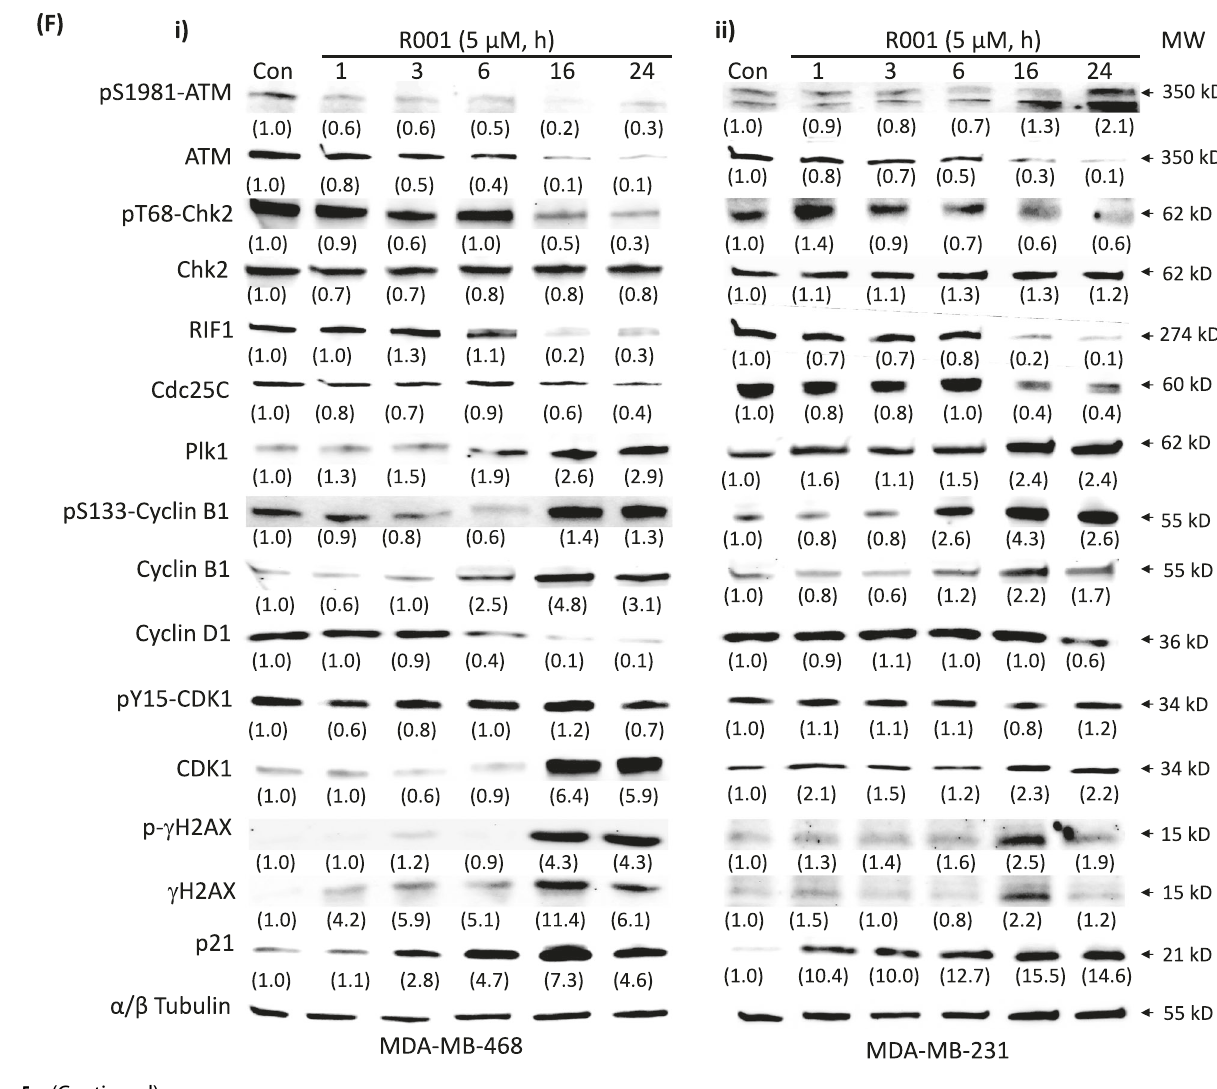
R001 strongly inhibits growth of subcutaneous human breast cancer xenografts in mice associated with reduced levels of G6PD and Trx1 and phospho-tyr STAT3 We determined the antitumor effects of R001. Daily oral gavage dosing of 5 mg/kg R001 inhibited in vivo growth in mice of MDA-MB- 468 subcutaneous xenografts that harbor aberrantly active